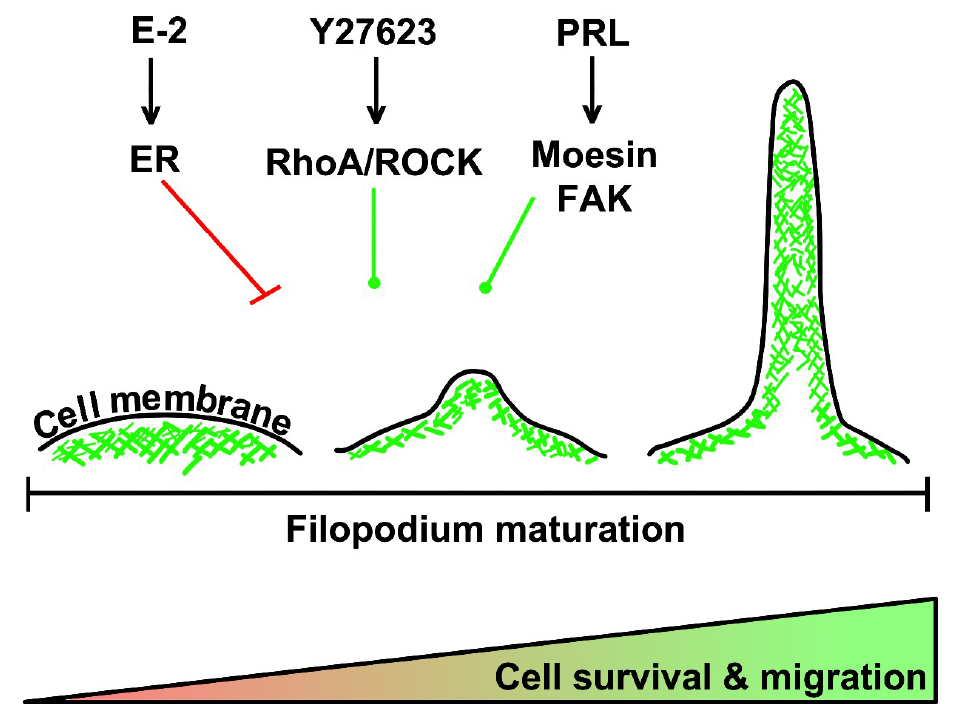
Figure 3. Membrane rearrangement is a pre-requisite for filopodium maturation, cancer cell migration, and metastasis. Di ff erent compounds can act on actin reorganization; for example, E2-treated cells display fewer protrusions and more cortical actin bundles, thus, blocking tumor cell migration. ROCK inhibitor (Y27623) causes a decrease in cortical actin bundles and concomitantly enhances protrusive activity, promoting cell migration and metastasis. Actin reorganization is also mediated by PRL, which controls moesin and FAK proteins, both involved in pseudopodia formation and cell migration.